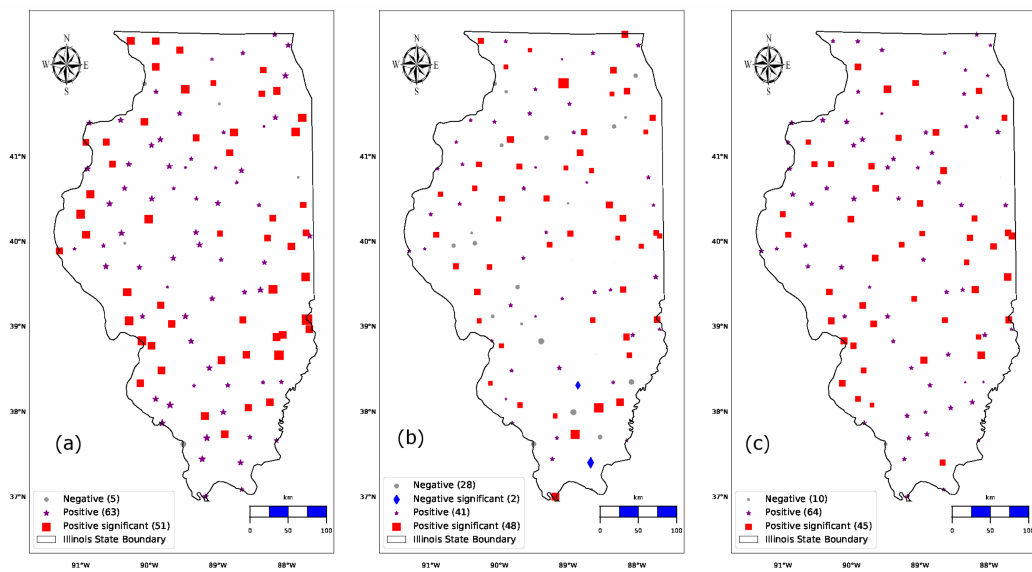
Figure 3. Distribution of trends in the annual precipitation parameters: ( a ) annual rainfall, ( b ) annual rainy days, and ( c ) number of days when rainfall is higher than the 90th percentile. In all the figures, the marker sizes have been scaled to represent the magnitude of the Theil–Sen